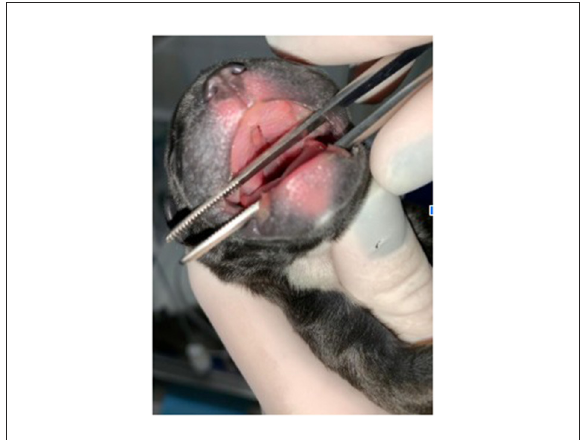
FIGURE1 Cleft Palate in a French Bulldog neonate.